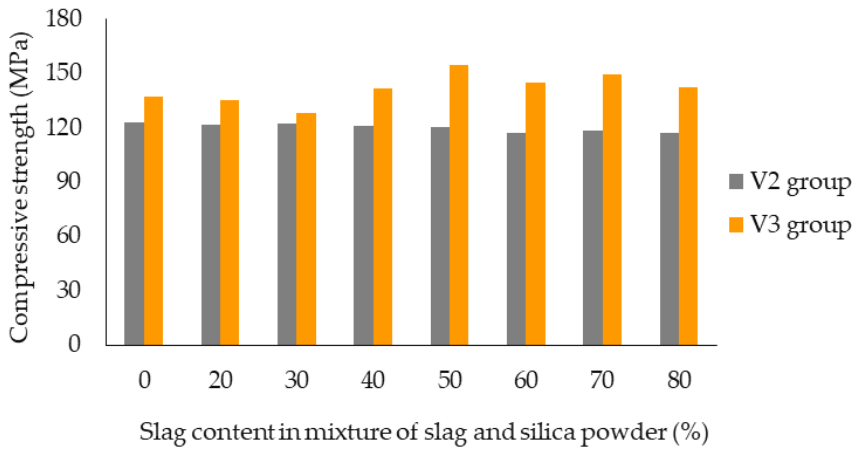
Figure 10. Compressive strength of V2 and V3 groups at 28 days.